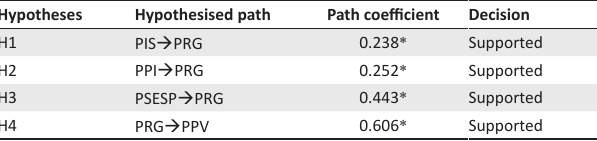
PRG, perceived raltional governance. * Statistics significant at the 5 %